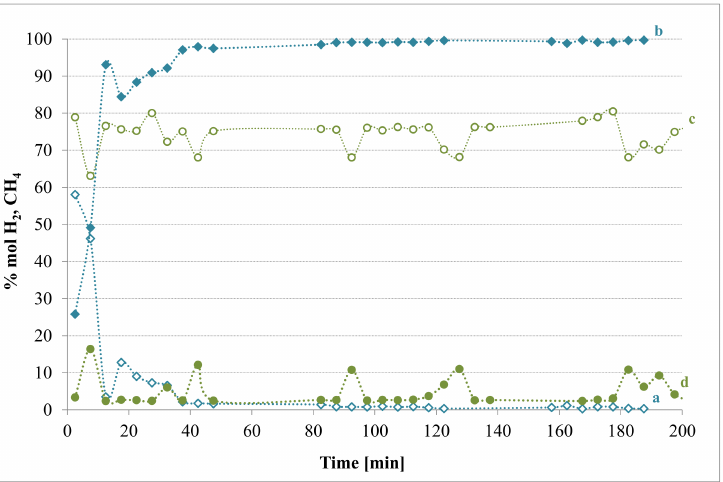
Figure 9. (a) H 2 and (b) CH 4 mol% during the SEMR with C56Ni3 and (c) H 2 and (d) CH 4 mol% during the SEMR with